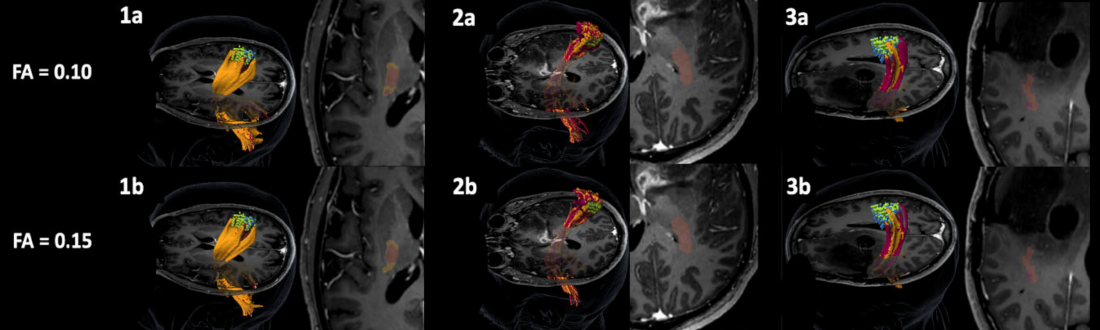
cases ( 1 , 2 , and 3 ) for di ff usion tensor imaging fiber tracking (DTI FT) of the CST using motor maps derived from single-pulse navigated transcranial magnetic stimulation (sp-nTMS; blue points) and paired-pulse nTMS (pp-nTMS; green points) for tractography with a fractional anisotropy (FA) of 0.1 ( a ) and 0.15 ( b ), respectively. The CST tracked by using sp-nTMS motor maps is highlighted in red, the CST derived from tracking with pp-nTMS motor maps is shown in